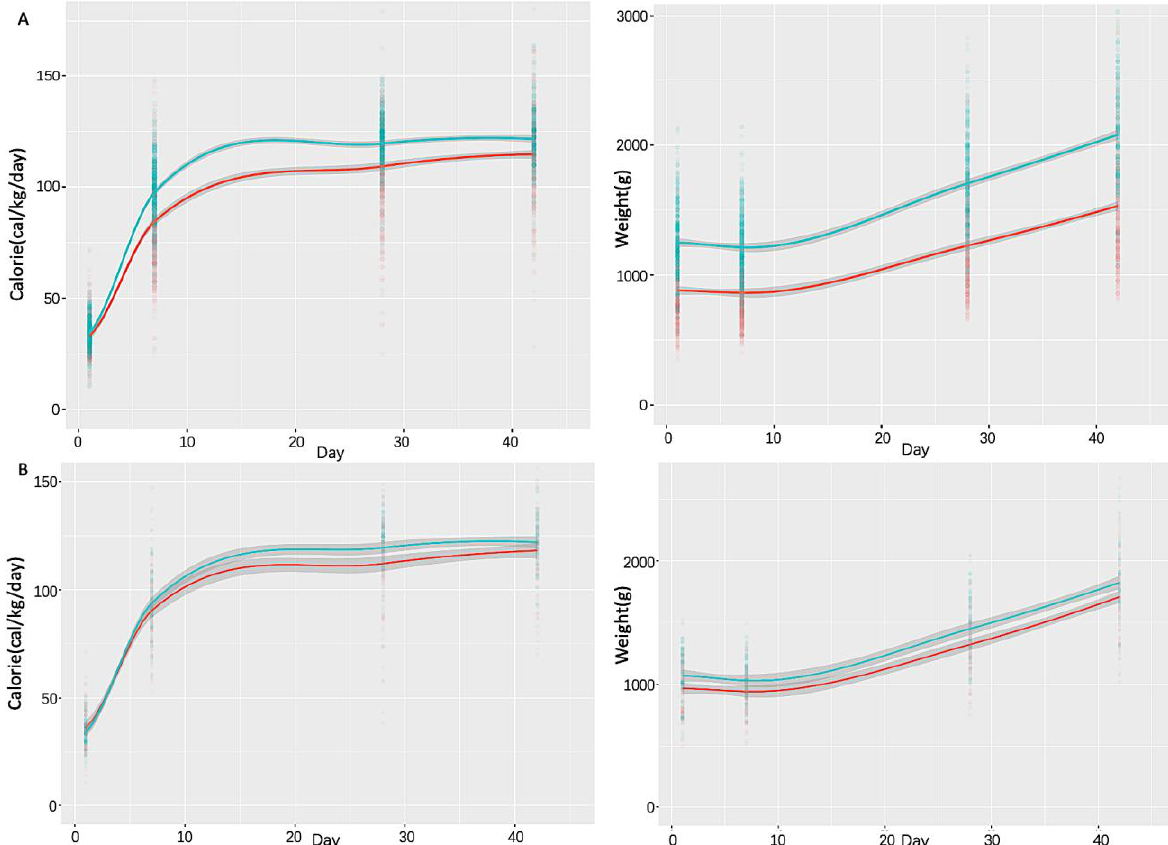
Figure 1. Longitudinal comparisons of body weight and weight-adjusted calories received over the first 6 weeks of life between BPD cases and control infants of ( A ) the primary cohort and ( B ) the sub-cohort whose gestational age (GA) ranged from 27 to 28 weeks.